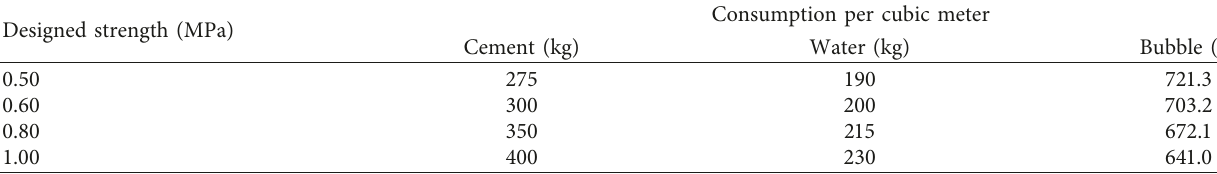
Table 2: Proposed mix proportions by CJJ/T177.